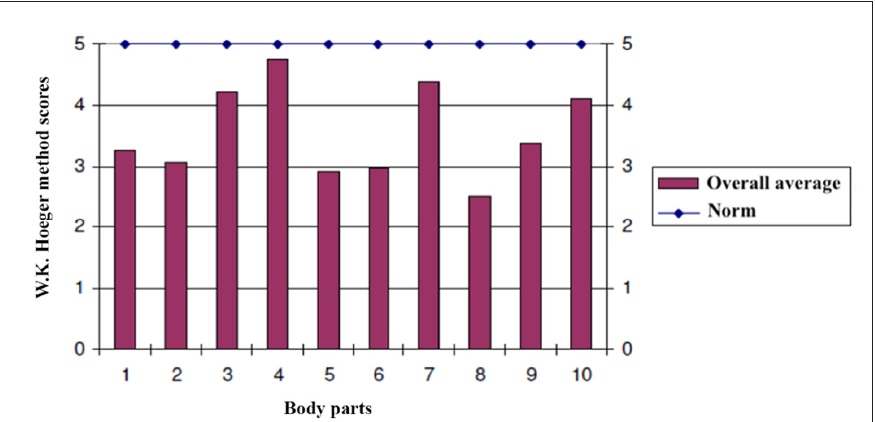
Figure. Assessment of individual body parts of children with abnormal posture by W.K. Hoeger Method